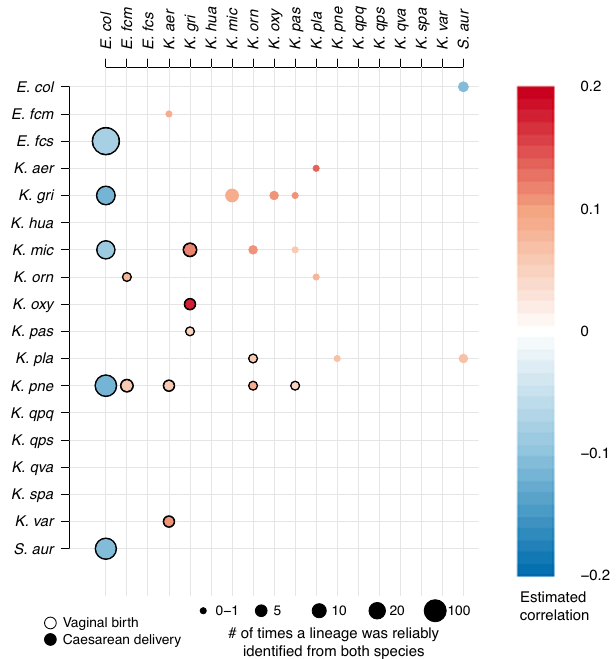
Fig.1|Correlationsbetweentheidenti fi edprioritypathogens. The fi gureshows only the statistically signi fi cant ( p <0.05, two-tailed permutation test) positive and negative correlations for the focus pathogen species. Correlations shown with a blackborderaroundthecircleareforthevaginaldeliverycohort(belowdiagonal), and correlations withoutaborderforthe caesareansection deliverycohort(above diagonal). Darker shades of red and blue represent stronger positive and negative correlation, while areas of the circles are proportional to the number of samples where the correlated pair was reliably identi fi ed. The correlation values were esti- mated from the relative abundance estimates. The exact p -values are available in the GitHub repository containing the plotting scripts used.